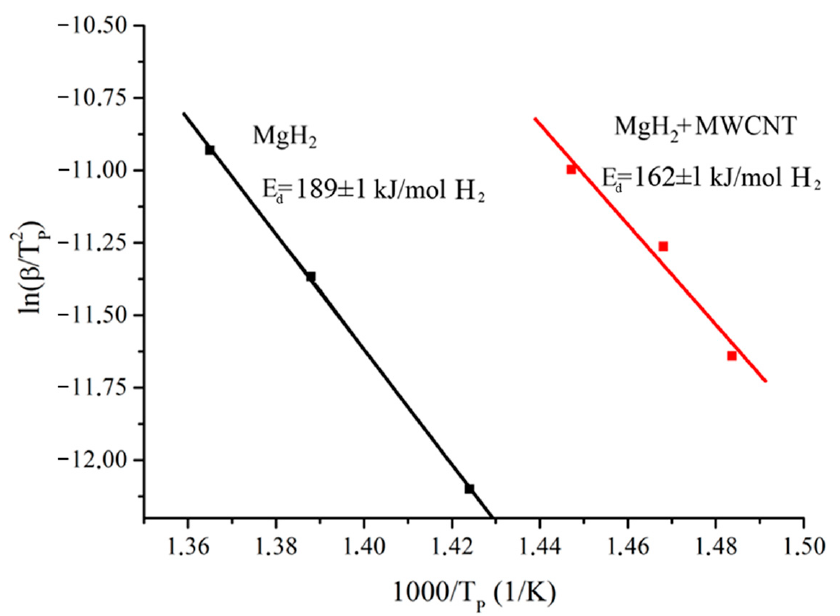
(cid:3081) (cid:2869)(cid:2868)(cid:2868)(cid:2868) Figure 11. Graphs of ln β Figure 11. Graphs of 𝑙𝑛 versus for MgH 2 and MgH 2 –5 wt.% SWCNT composite obtained versus 1000 for MgH 2 and MgH 2 –5 wt.% SWCNT composite obtained T p T 2 P (cid:3021) (cid:3265)(cid:3118) (cid:3021) (cid:3291) with a milling duration of 180 min at a speed of 300 rpm. with a milling duration of 180 min at a speed of 300 rpm. Table 1. Calculation of the activation energy of hydrogen Figure 11. Graphs of 𝑙𝑛 (cid:3081) versus (cid:2869)(cid:2868)(cid:2868)(cid:2868) for MgH 2 and MgH 2 –5 wt.% SWCNT composite obtained (cid:3021) (cid:3265)(cid:3118) (cid:3021) (cid:3291) with a milling duration of 180 min at a speed of 300 rpm.